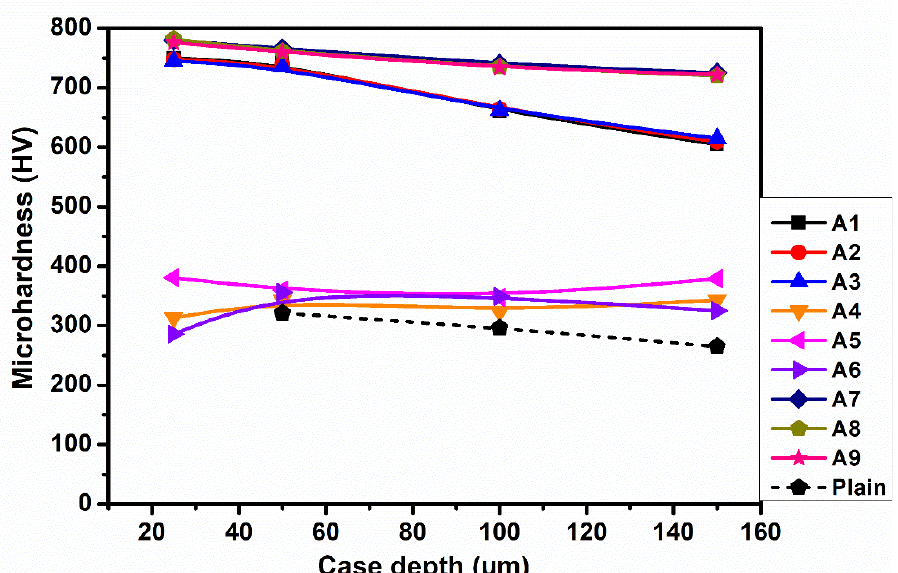
Figure 6. Microhardness profile of transverse sections of impregnated and plain EN 31 specimen A type pins, i.e., at 1200 °C.